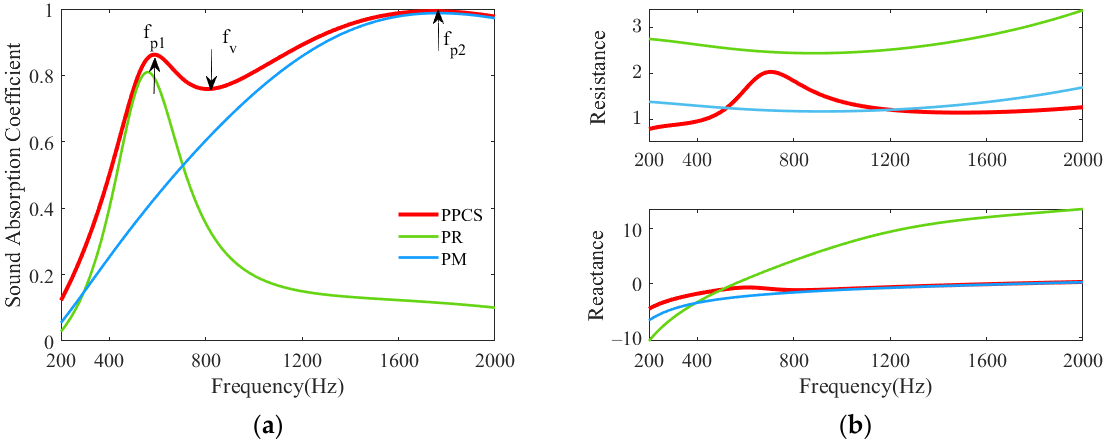
Figure 5. Sound absorption of PPCS and its components PR and PM. ( a ) Sound absorption coefficients; ( b ) normalized surface acoustic impedance.